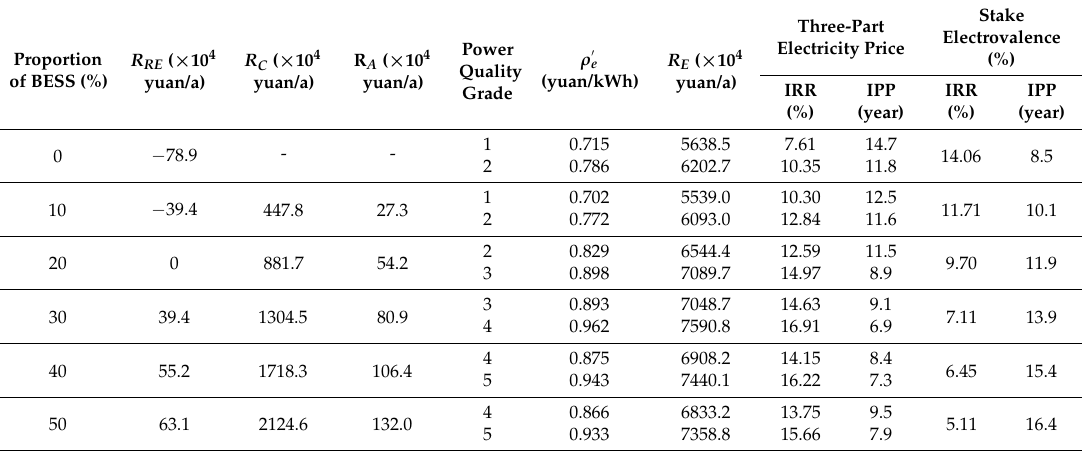
Table 10. The comparison of the economic income and internal rate of return (IRR) of the 50 MW PV plant with different capacities of energy storage